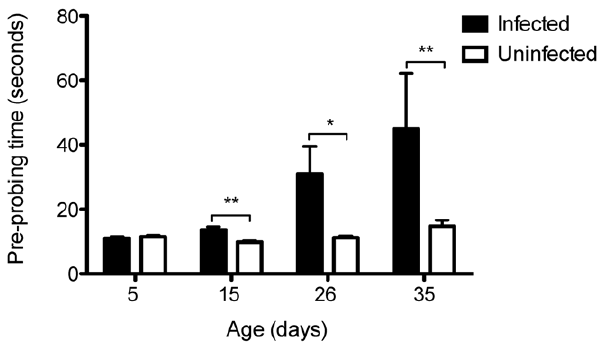
(black bars) or tetracycline treated counterparts (white bars) of different ages (5, 15, 26 and 35 days) after landing on a human hand until the insertion of mouthparts into the skin ( N =12–40 per group). Bars depict means 6 S.E.M. * p , 0.05; ** p , 0.01 by t-test.